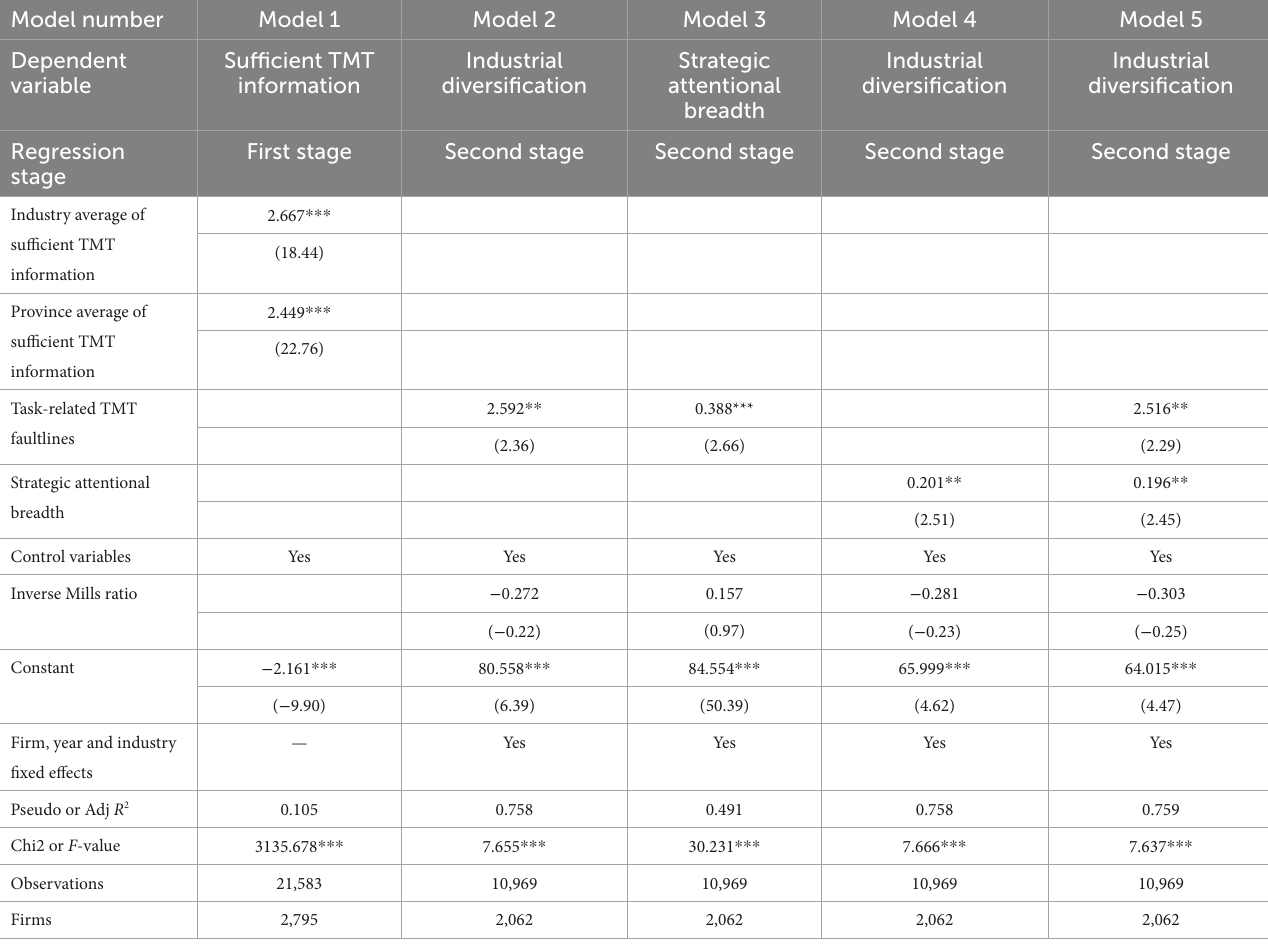
TABLE 6 Panel fixed-effects regression of the relationship between task-related TMT faultlines and corporate industrial diversification (using the Heckman model to mitigate sample selection